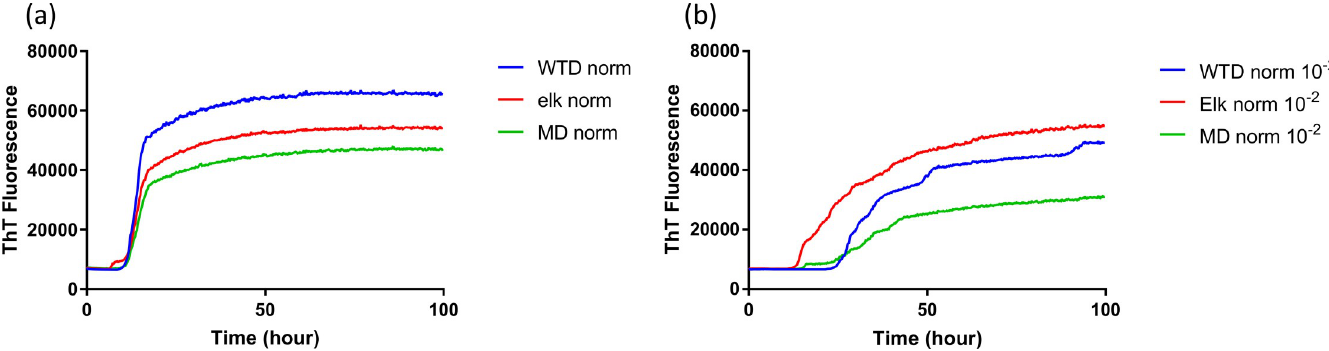
Fig 3. Comparison of averaged seeding activity of RT-QuIC reactions with BV rPrP seeded with brains from WTD inoculated with brains from different cervid species. (WTD: blue line, elk: red line, MD: green line). All assays seeded with (a) EIA normalized stock and (b) 10 − 2 dilution of WTD brains inoculated with each CWD source was averaged and compared to assays seeded with two other CWD inocula. Data are presented as mean ThT fluorescence of 4 repeated reactions.